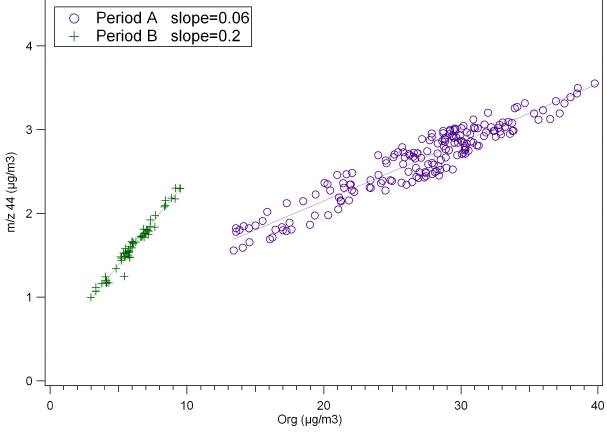
Fig. 6. m/z 44 vs. the total organics at the two periods. Period A: the burning event (marked by purple circles) characterized by freshly emitted aerosols. Period B: the following day at noon (marked by green crosses) characterized by aged oxidized